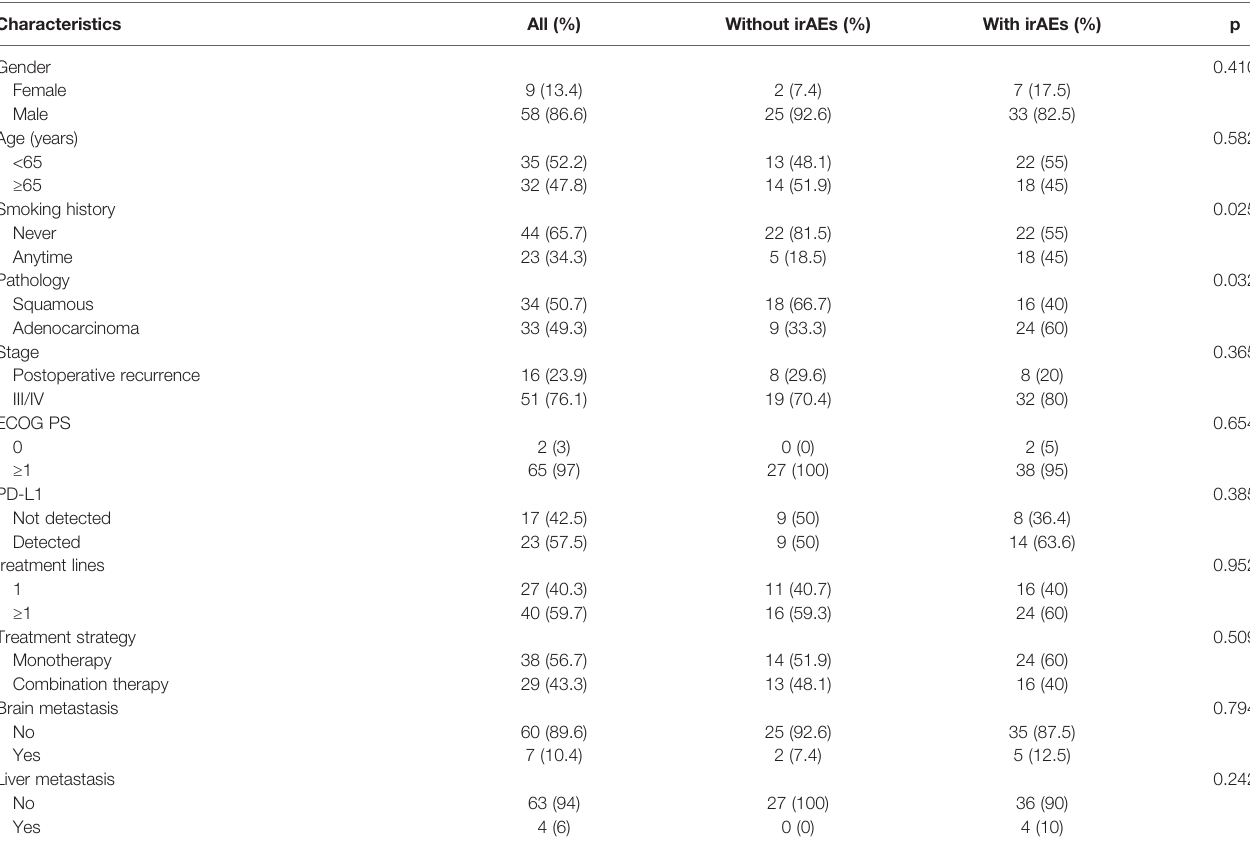
TABLE 1 | Baseline clinical characteristics of patients who received ICIs.